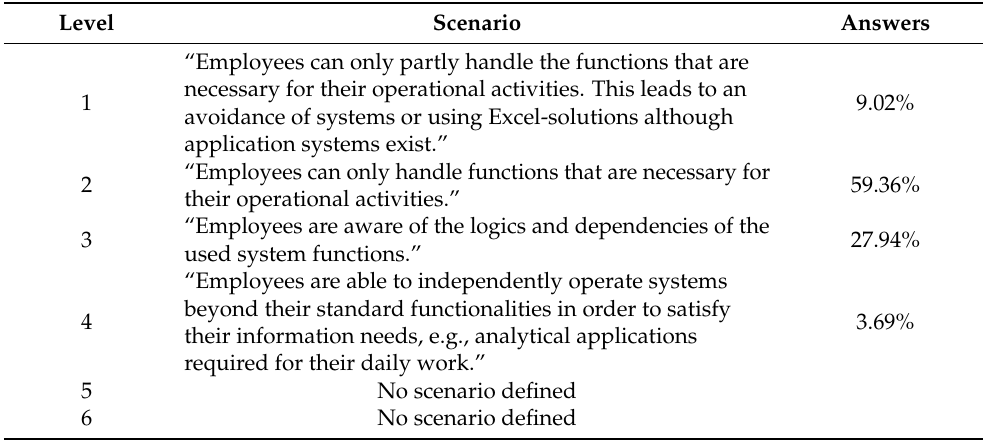
Table 9. Results for the capability “IT competencies of employees”.